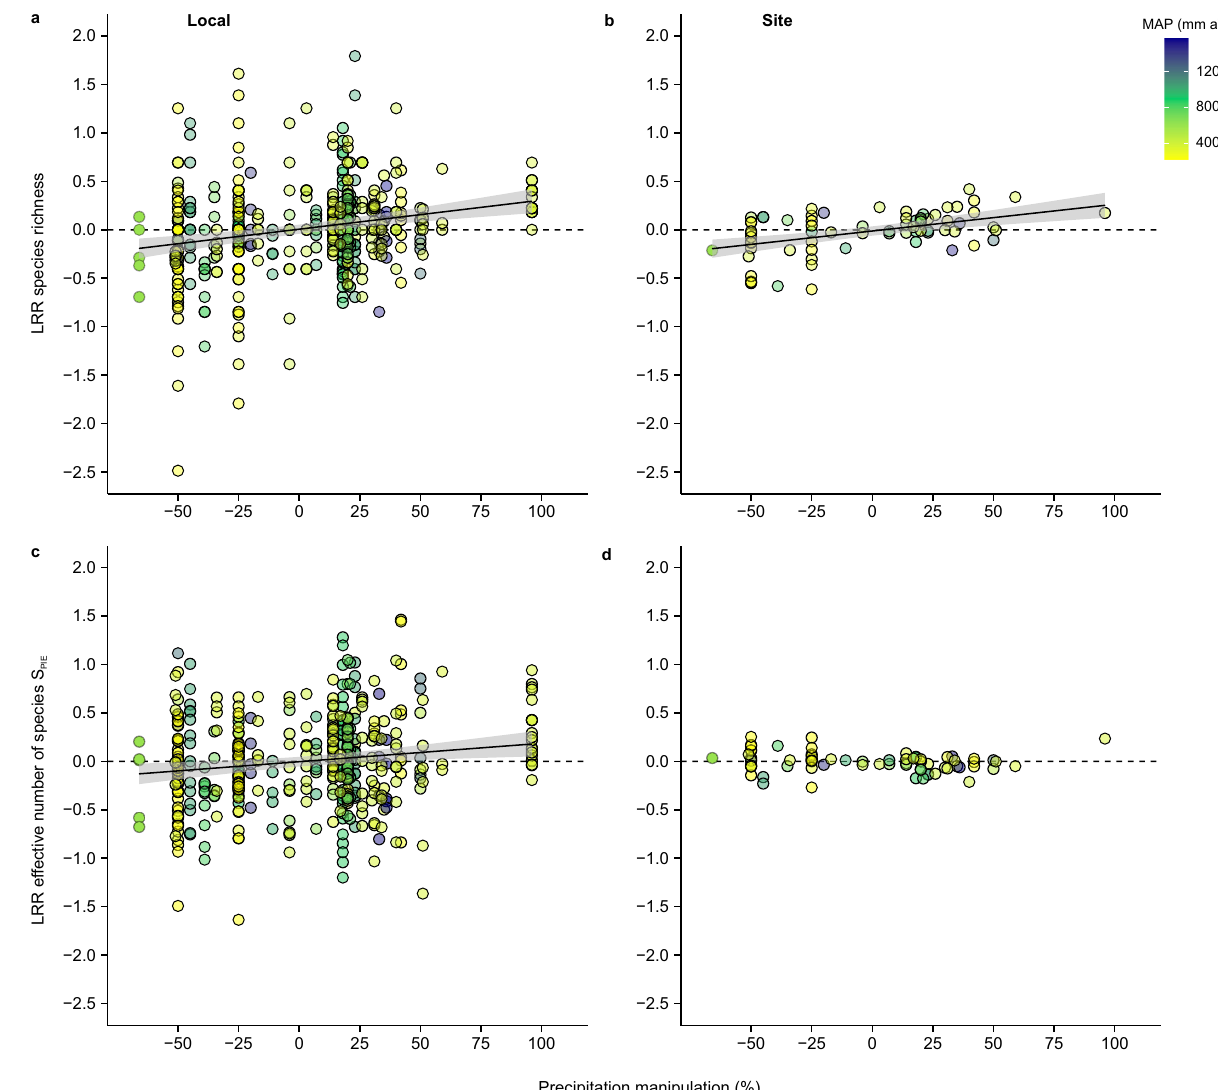
Fig. 1 Responses of plant diversity to precipitation manipulation at local and site scales. Effect of the magnitude of precipitation manipulation on the log response ratio (LRR) of species richness ( a , b ) and effective number of species — S PIE c , d ) at the local scale (i.e., plot scale; a , c ) and site scale ( b , d ). Data points represent log response ratios of original data ( n = 462 at the local, n = 72 at the site scale) and colors indicate the background mean annual precipitation (MAP). The linear regressions (mean and 95% con fi dence intervals) are based on predicted values of the simplest linear mixed effect model including magnitude of precipitation manipulation (Supplementary Tables 2 and